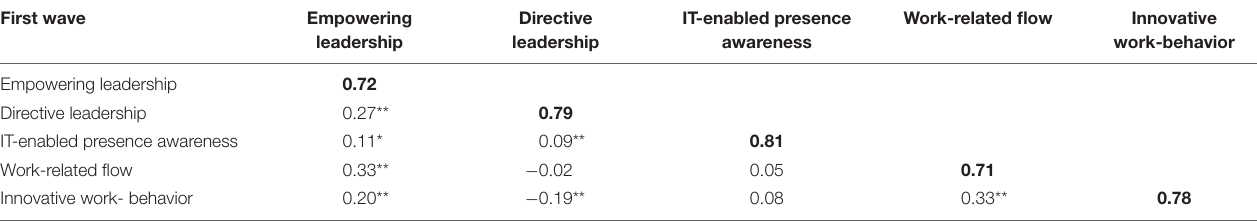
TABLE 4 | Correlations first wave and the square root of the Average Variance Extracted (in bold).